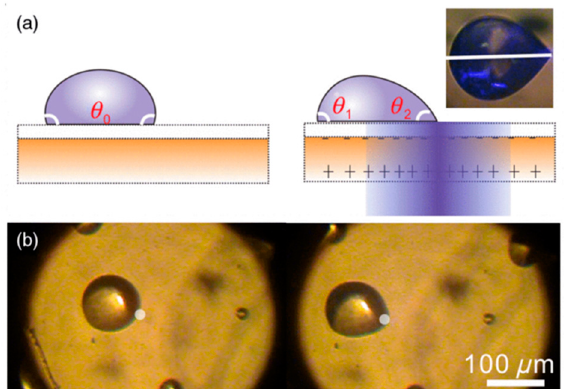
Figure 7. Schematic side view ( a ) and top photographs ( b ) of the micro-droplet deformation under the limbic laser illumination on the hydrophobic substrate. Reprinted with permission from Fan et al. Phys. Rev. Appl. 2017 , 7 , 064010. Copyright 2017 American Physical Society (reference [32]).